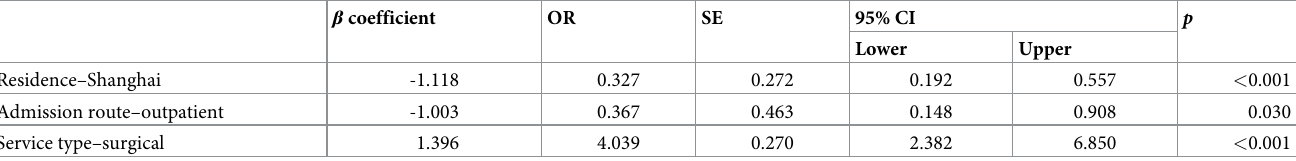
Table 3. Multivariate logistic regression analysis of inappropriate admissions.